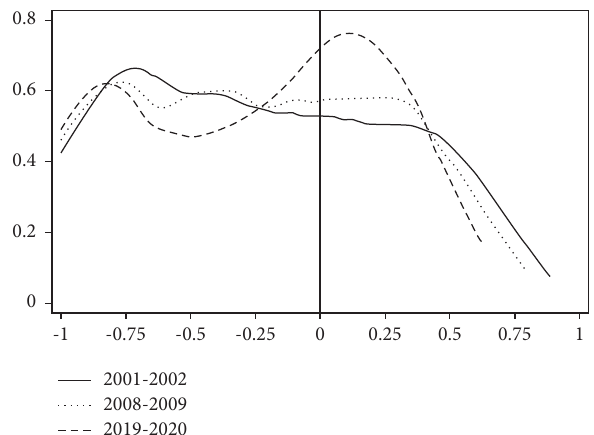
Figure 1: Kernel density estimation of Chinese RSCA index